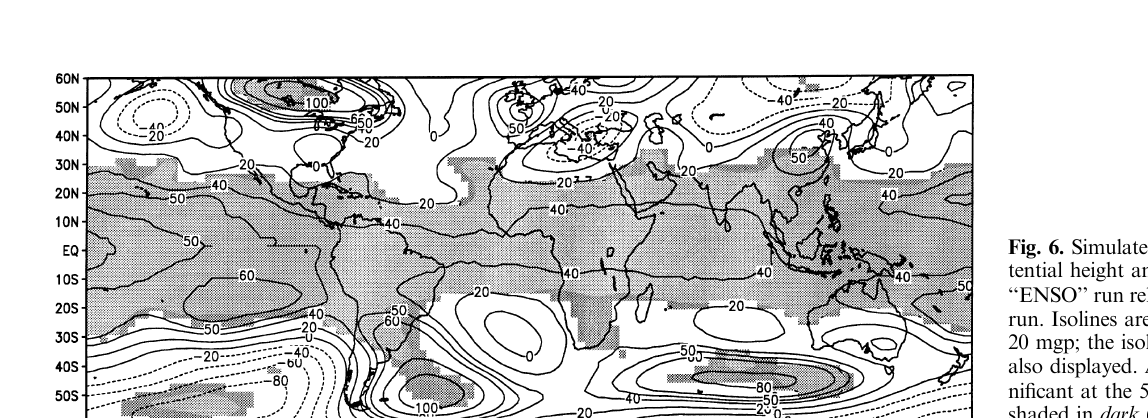
Fig. 5. Simulated rainfall anoma- lies for the ‘‘ENSO’’ run relative to the control run. Isolines are in mm day (cid:41) 1 . Anomaly areas signifi- cant at the 5% (1%) level are shaded in dark ( light ) grey